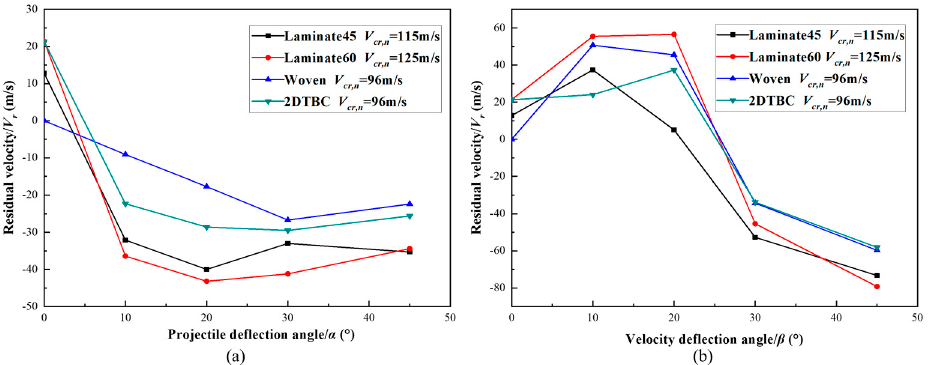
Figure 11. The relationship between deflection angles and residual velocity. ( a ) Relationship of projectile deflection angles α and residual velocity, ( b ) relationship of velocity deflection angles β and projectile residual velocity.